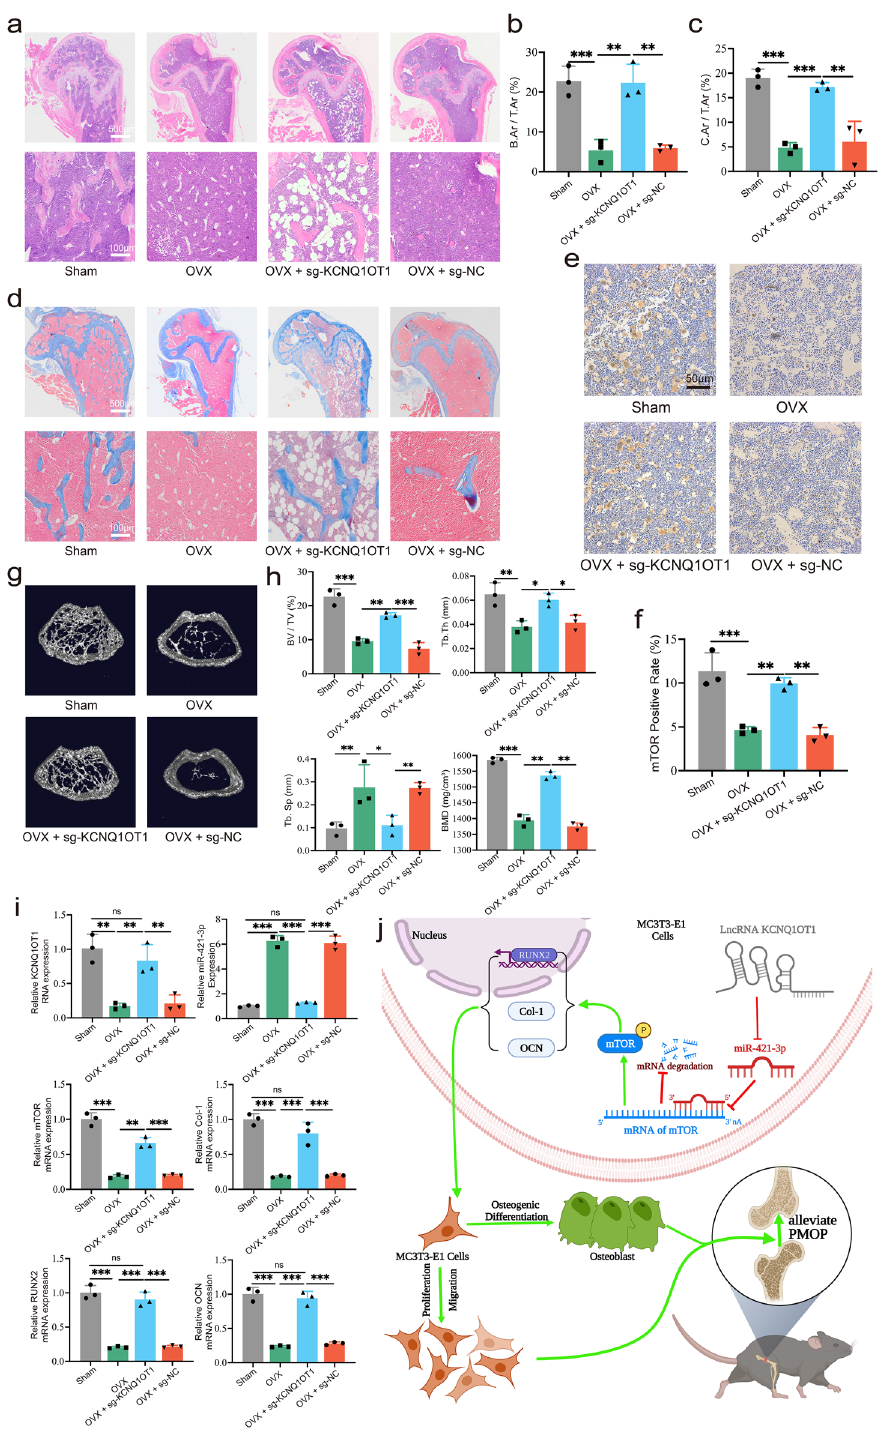
Figure 8. KCNQ1OT1 alleviates osteoporosis. Four groups of mice are as follows: (1) Sham, (2) OVX, (3) OVX + sg-KCNQ1OT1 AND (4) ovx + sg-NC (N = 3). ( a , b ) Each group’s mice distal femurs were stained with HE and bone area/total area (B.Ar/T.Ar) was analyzed via images of HE staining. ( c , d ) Each group’s mice distal femurs were stained with Masson and collagen area/total area (C.Ar/T.Ar) was analyzed via images of Masson staining. ( e ) IHC of mice femurs of each group. ( f ) mTOR positive rate was analyzed and calculated by IHC images of mice femurs. ( g ) Three-dimensional reconstruction of images from micro-CT of distal femurs from each group. ( h ) Parameters including bone mineral density (BMD), trabecular bone volume/tissue volume (BV/TV), trabecular separation (Tb.Sp) and trabecular thickness (Tb.Th) were analyzed by micro-CT. ( i ) Relative RNA expression of KCNQ1OT1, miR-421-3p, mTOR, Col-1, RUNX2 and OCN of mice femurs was performed by qRT-PCR. ( j ) KCNQ1OT1 sponges miR-421-3p to positively regulate mTOR expression at the post- transcriptional level, thereby enhances MC3T3-E1 cell function on proliferation, migration, and osteogenic differentiation in vitro and alleviates PMOP in vivo. *P < 0.05, **P < 0.01, ***P <